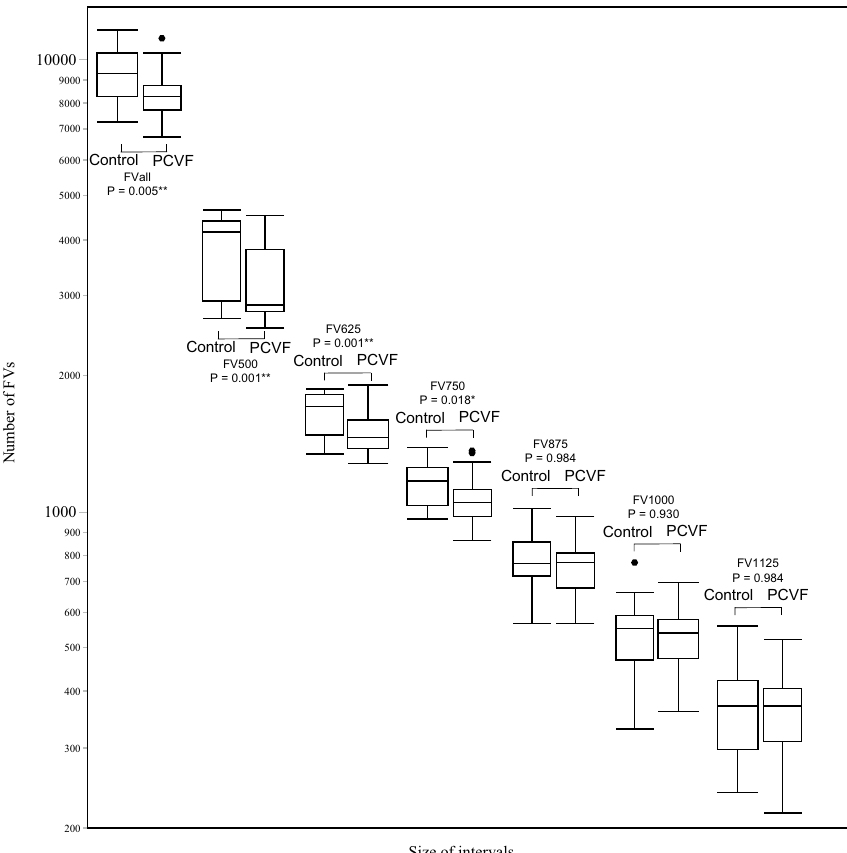
Figure 4. Comparison of FVs between PCV fellow eyes and controls. P P value of independent-samples median test. The number of FVs was significantly lower in the PCVF group compared to the controls in FVall, FV500, FV625, and FV750. There were no differences between the two groups in FV875, FV1000, and FV1125. *P < 0.05, **P < 0.01. FV choriocapillaris flow void, Control control group, PCVF PCV fellow eyes, FVall FV sizes from 400 to 25,000 μm 2 . FV500: FV sizes from 400 to 500 μm 2 . FV625: FV sizes from 525 to 625 μm 2 . FV750: FV sizes from 650 to 750 μm 2 . FV875: FV sizes from 775 to 875 μm 2 . FV1000: FV sizes from 900 to 1000 μm 2 . FV1125: FV sizes from 1025 to 1125 μm 2 .